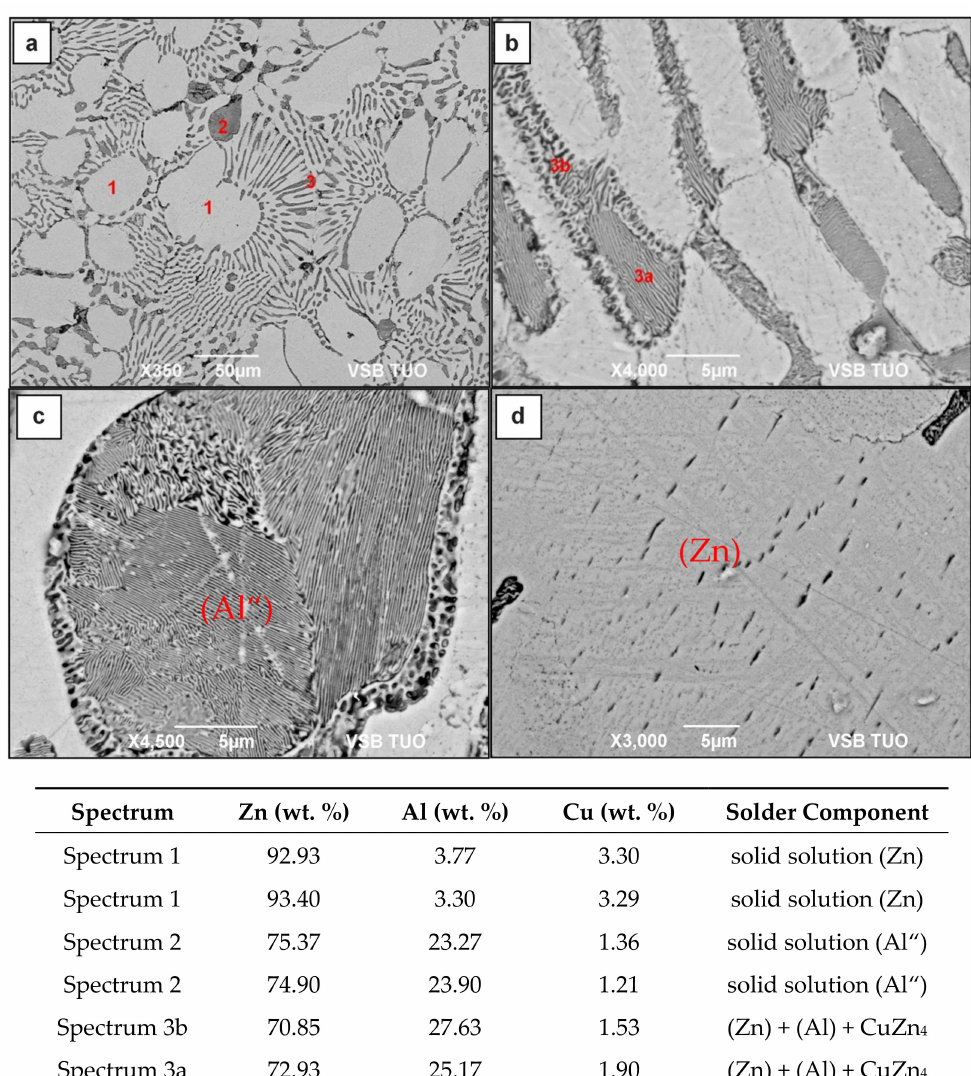
Figure 8. SEM/EDX analysis of ZnAl5Cu3 solder: ( a , b ) points of measurement in individual spectra; ( c ) detail of zone 2; ( d ) detail of zone